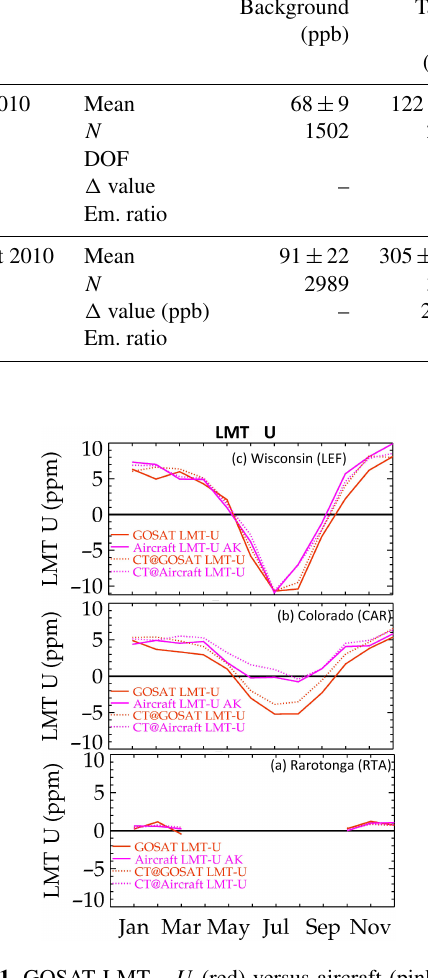
Table 8a–c give the bias, standard deviation, and error with averaging for LMT – U . In Table 8a, the GOSAT bias and bias variability of (LMT – U ) improves over the prior for all cases. The bias variability of 0.3, 0.9, and 0.8 ppm of (LMT – U ) for HIPPO ocean, ESRL ocean, and ESRL land, re- spectively, is comparable to the LMT bias variability of 0.3, 1.0, and 1.0 for the same categories. In Table 8b, the 15- observation average standard deviation for GOSAT LMT